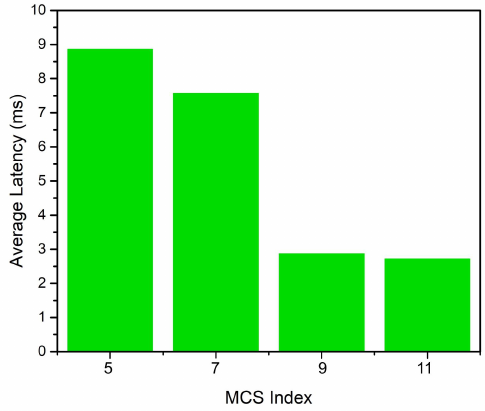
Figure 9. Impact of MCS index on the average